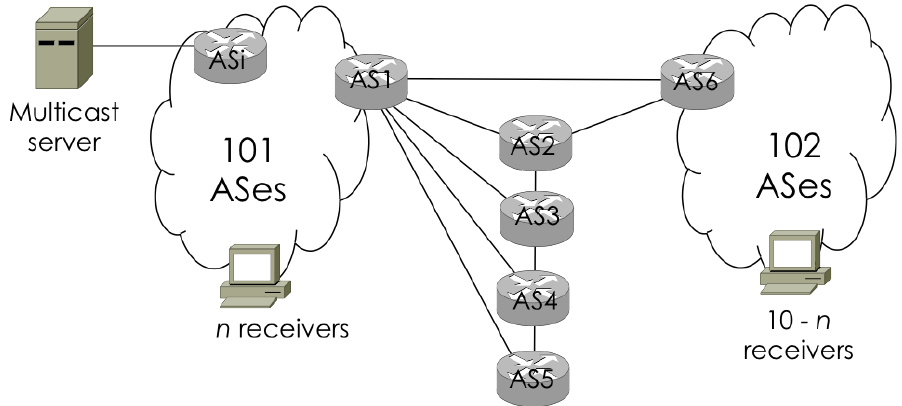
Figure 10. Particularity of the AS1-AS6